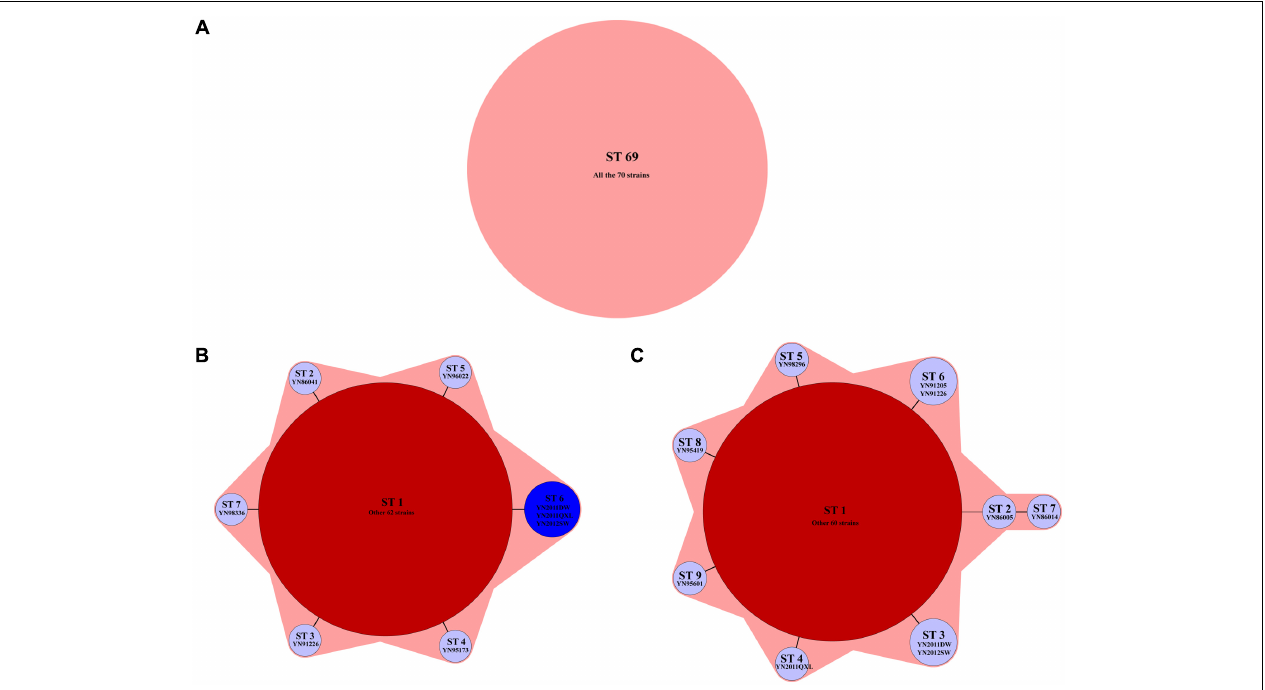
FIGURE 2 | The minimum spanning tree of three sequence based genotyping methods. (A) Seven housekeeping genes: all the strains belonged to ST69; (B) nine housekeeping genes: seven STs were found by using this method, named as ST1–ST7. The typical isolates were shown below each STs; and (C) virulence genes: nine STs were found by using this method, named as ST1–ST9. The typical isolates were shown below each STs.